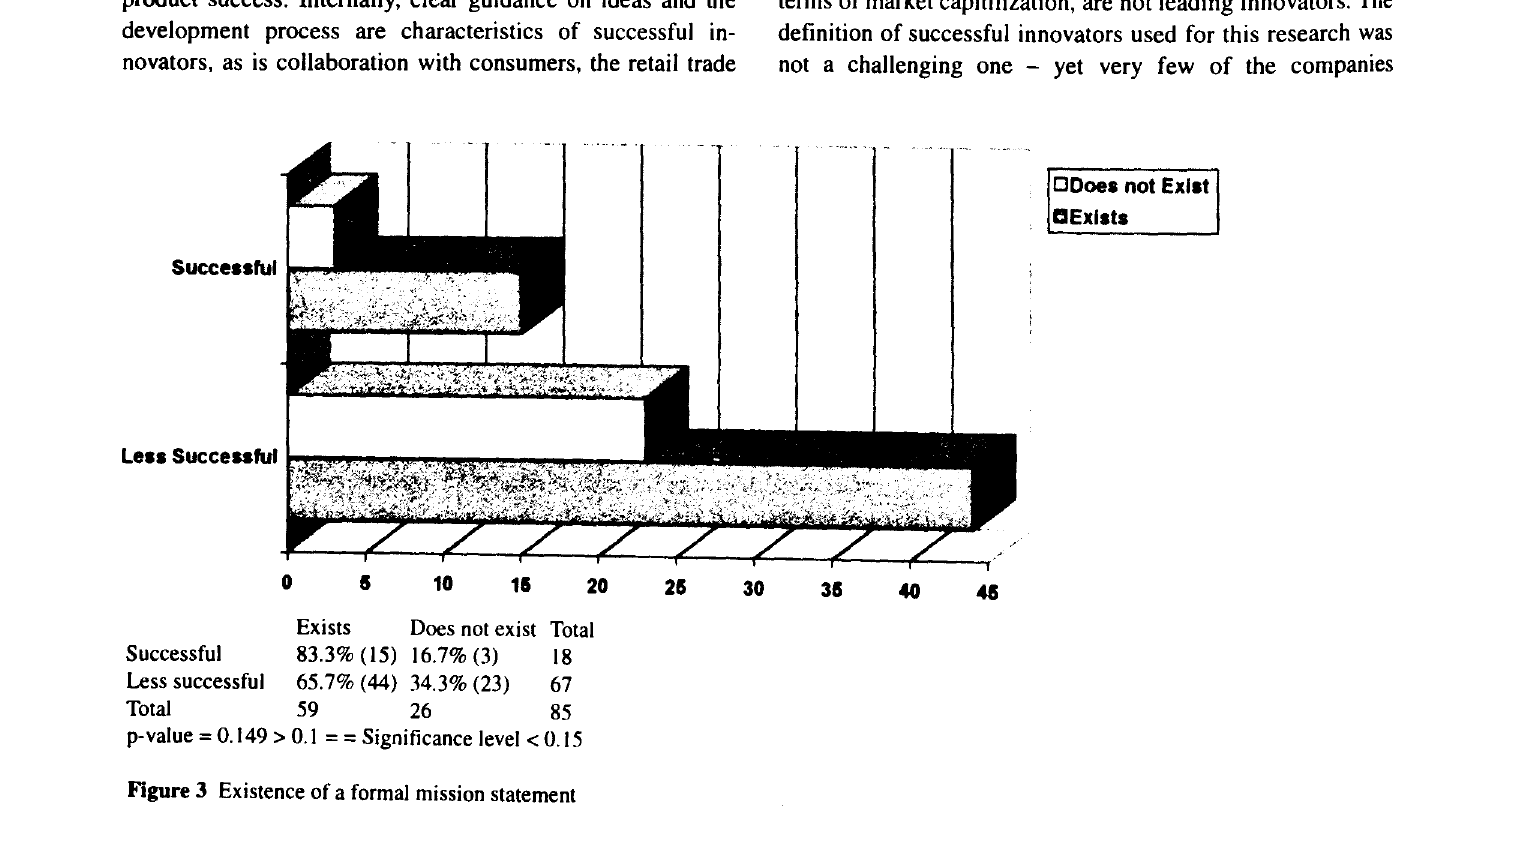
Figure 3 Existence of a formal mission